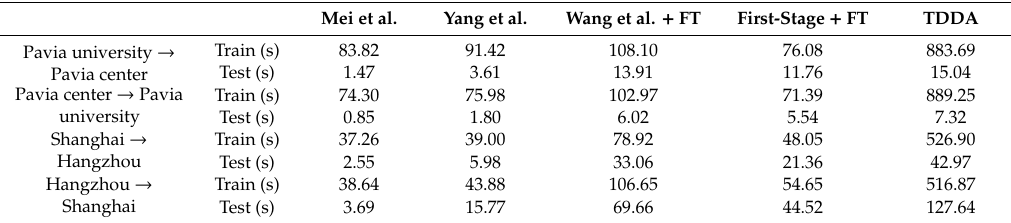
Table 10. Training and test time for each method in four